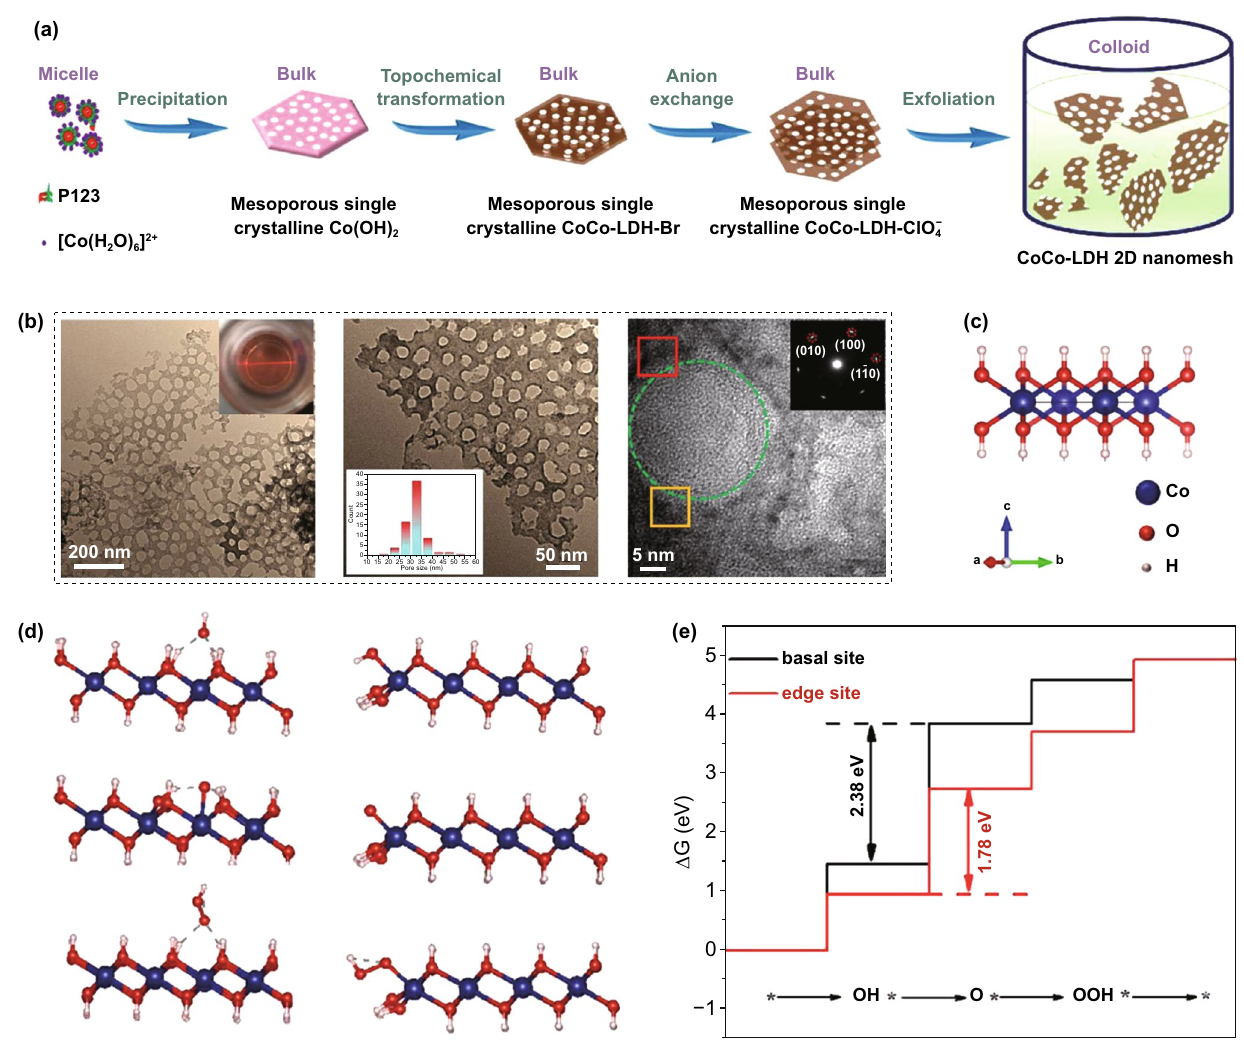
Fig. 10 CoCo-LDH 2D nanomesh for enhanced oxygen evolution. Reproduced with permission [346]. Copyright 2019,